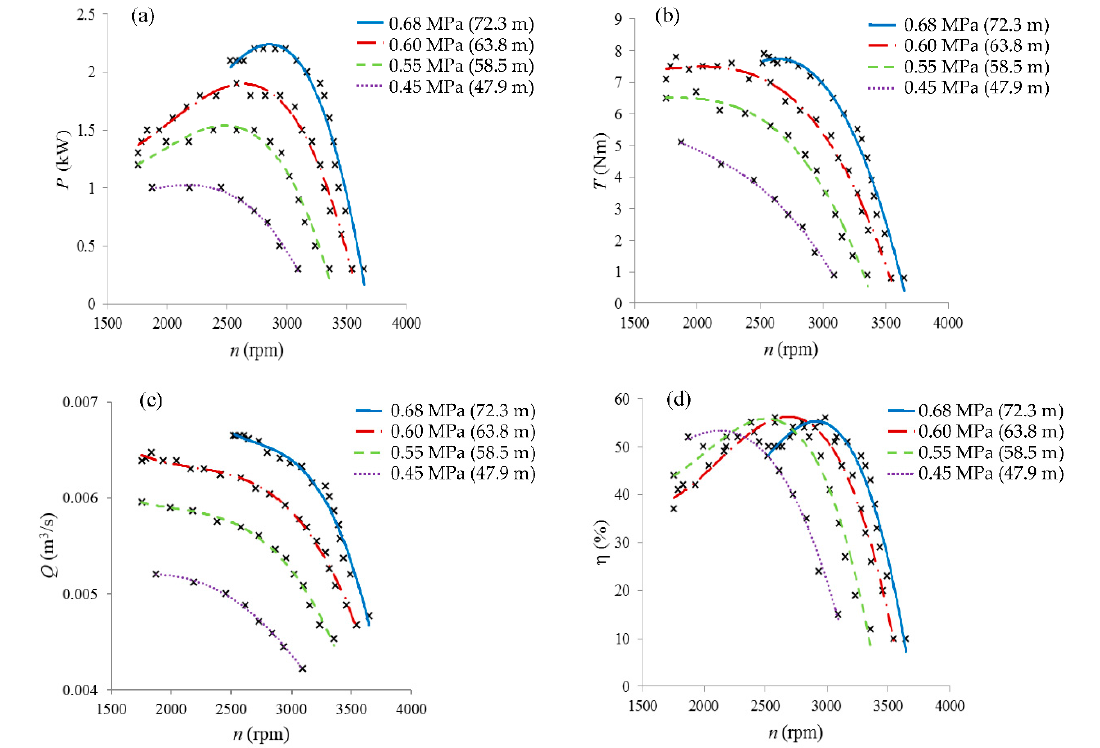
Figure 9. Characteristic ERPR curves of: ( a ) PEU active power; ( b ) calculated turbine torque; ( c ) flow rate; and ( d ) total efficiency in turbine speed domain under four reduced pressure values.